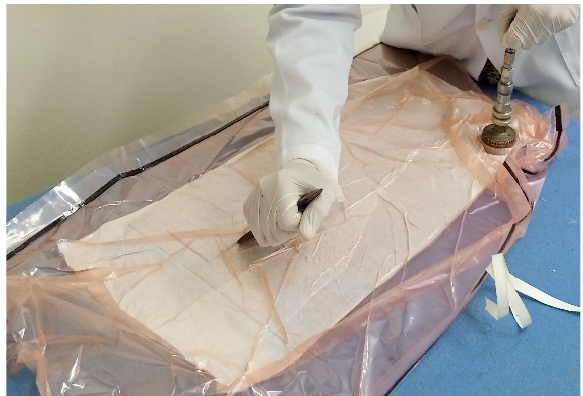
Figure 3. Vacuum bagging of the laminate before curing.